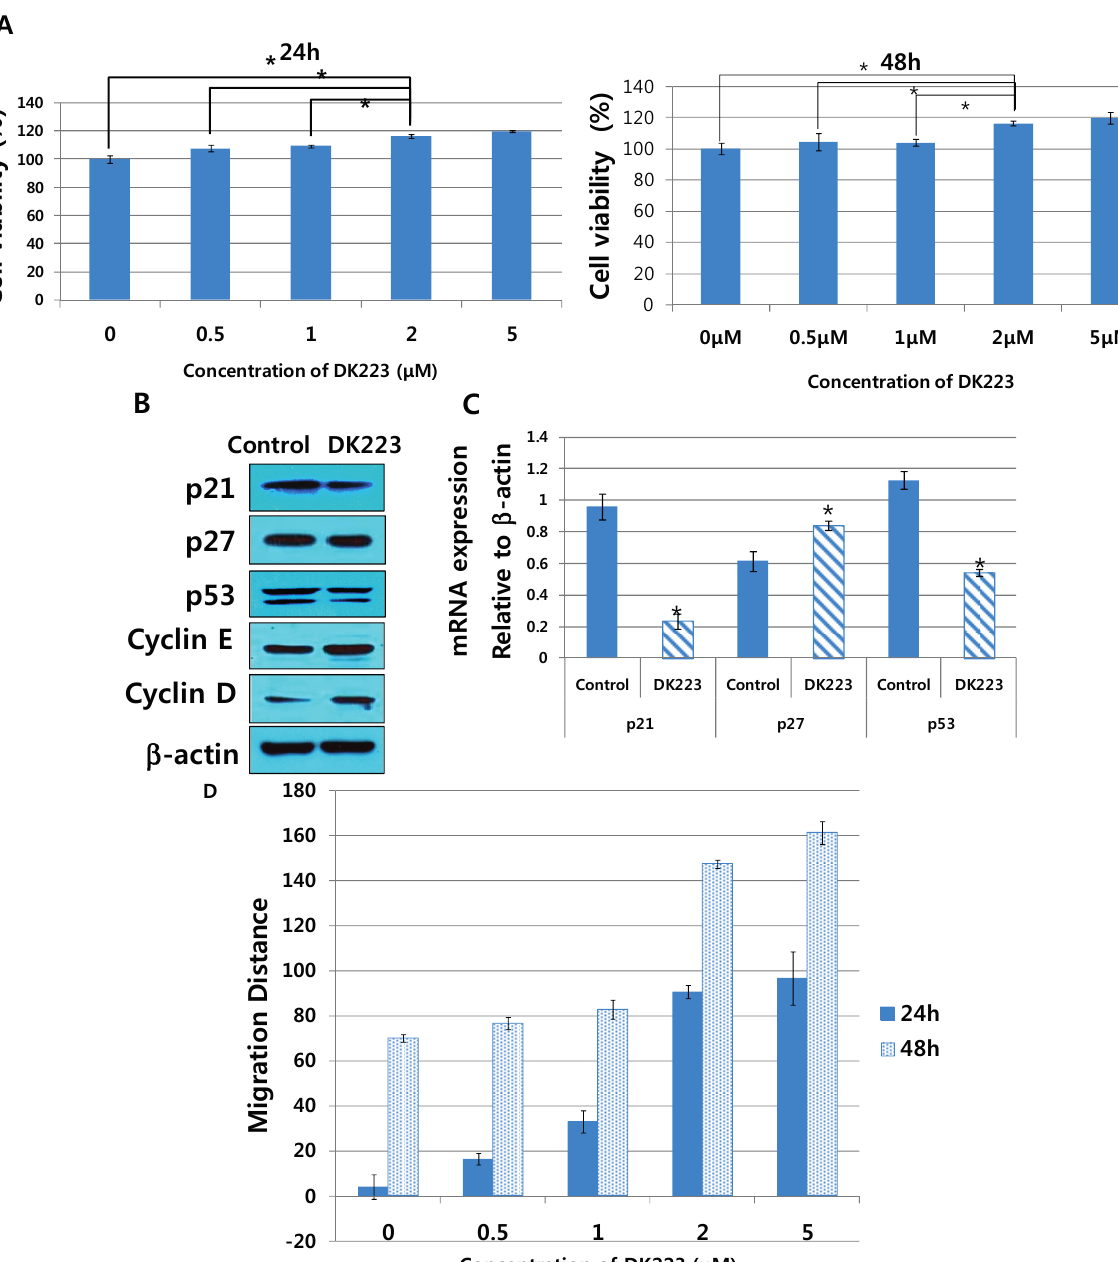
Figure 5. Proliferation and migration of dermal fibroblasts treated with DK223 and expression of cell- cycle-related genes in dermal fibroblasts after incubation with DK223. ( A ) Human dermal fibroblasts were seeded at a density of 3 × 10 4 /mL for 24 and 48 h before treatment. MTT assay was performed as described previously; ( B , C ) The expressions of cell cycle-related genes, such as p21, p53, p27, cyclin E, cyclin D, were examined by Western blot and RT-PCR in 24 h as described previously; ( D ) Cells were seeded at a density of 3 × 10 4 /mL 24 h before the scratch test. Scratch widths were measured 48 h after DK223 treatment. A histogram shows the results of ImageJ data analysis. Data are represented as the mean distance percentages ± SD from at least three replicates, * p < 0.05 in all under